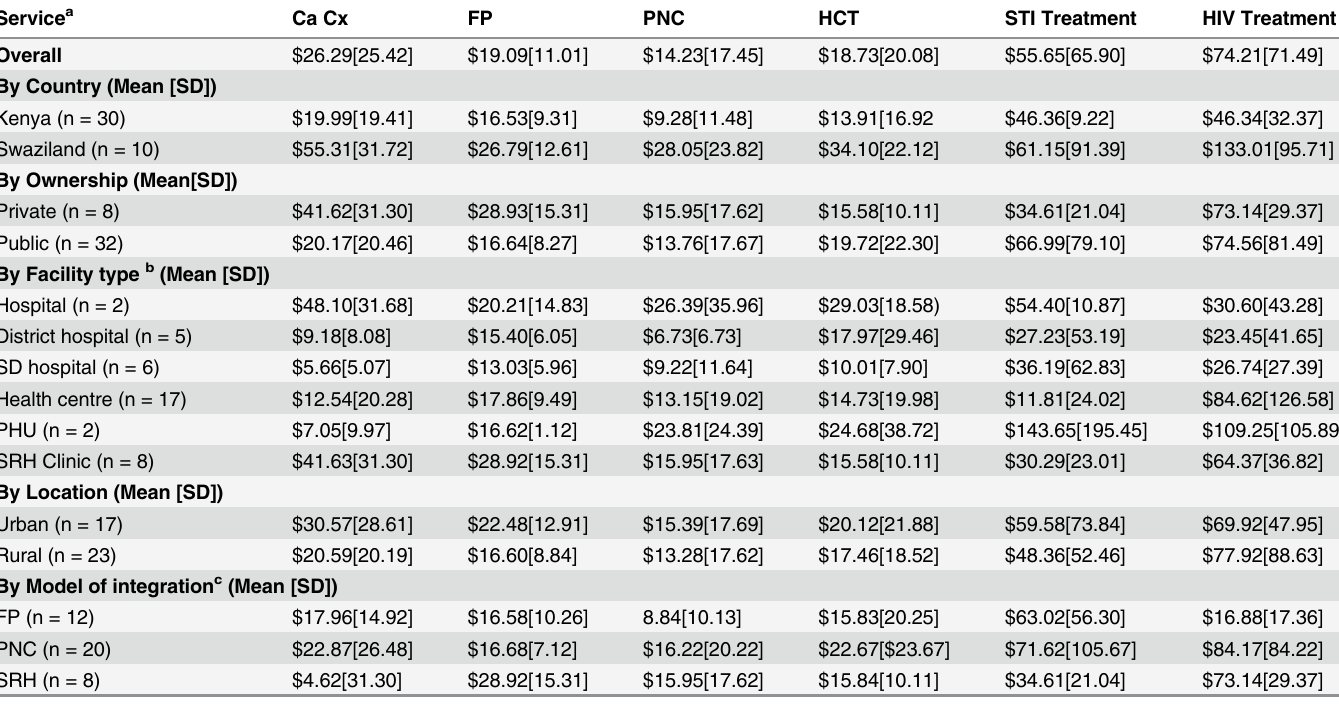
Table 3. Mean unit cost per service * (Int$ 2013) by country and facility